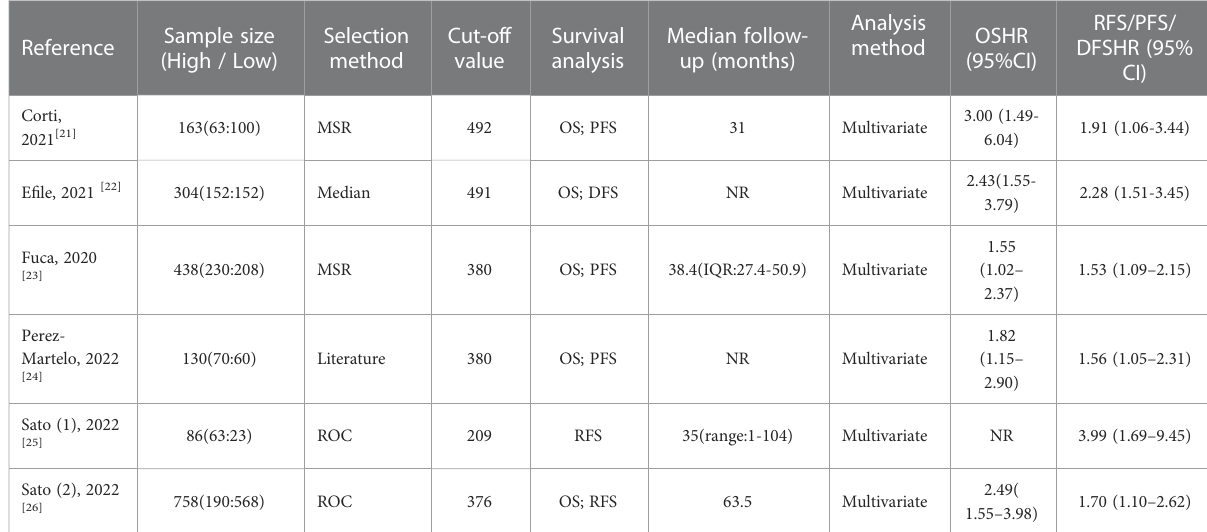
TABLE 2 Survival information of included studies.